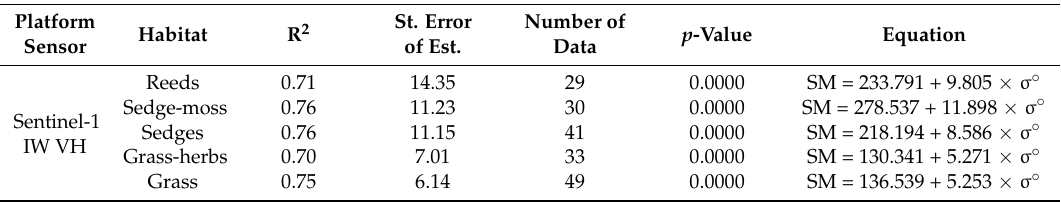
Table 4. Results of relationships at a 95% confidence level between measured soil moisture (SM) and σ ◦ calculated from Sentinel-1A VH